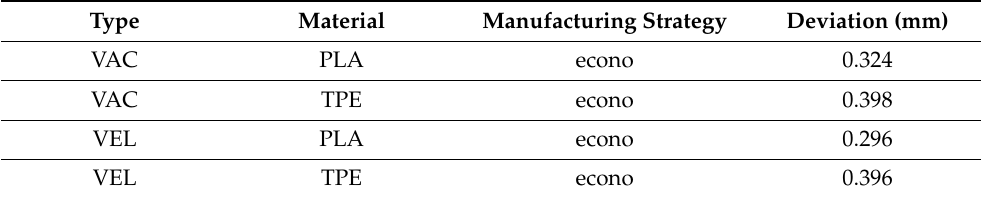
Table 2. Deviation of fit between sockets and the stump.